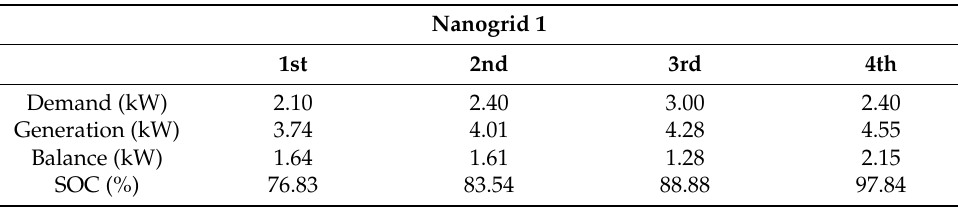
Table 3. Operation planning of HEMS1 in the absence of service.